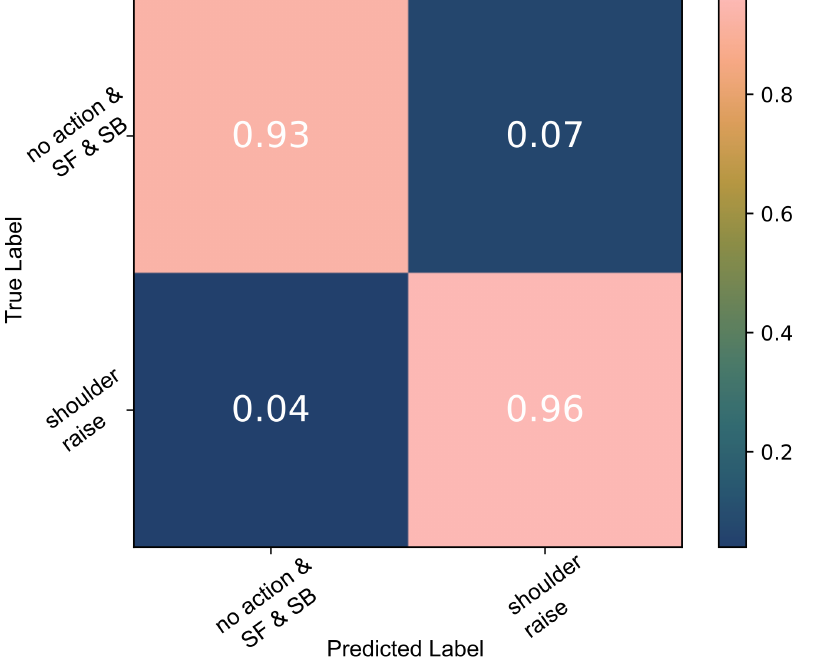
Figure 5. The thresholding algorithm SR classification results of able-bodied participant data; the model was tested against SR , SF and SB